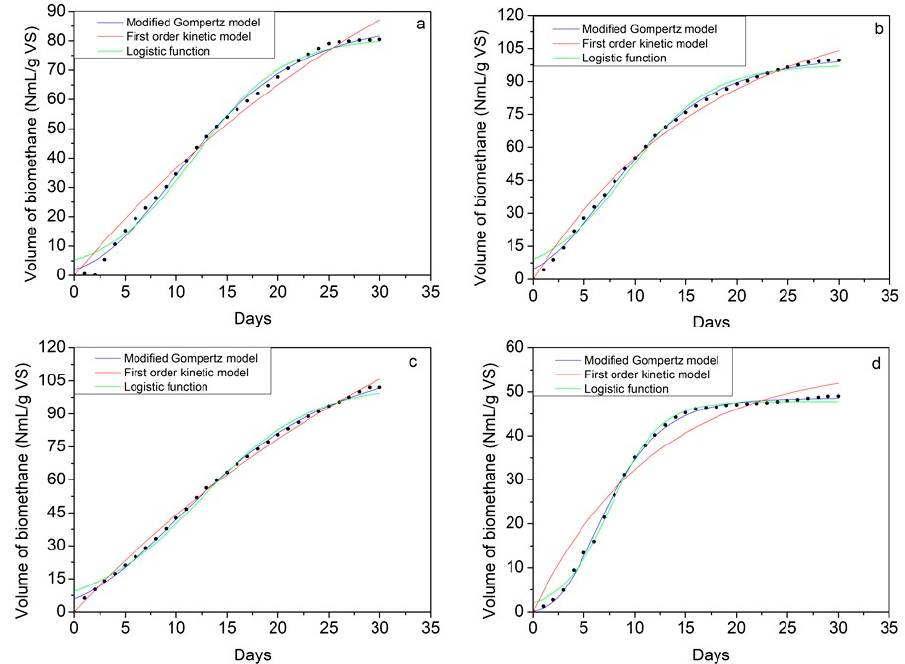
Figure 5. Experimental data fitted by the modified Gompertz, the first-order kinetic model, and the logistic function model—( a ) sample S , ( b ) sample S +5 , ( c ) sample S +10 , ( d ) sample S +50 . All of the parameters estimated using the three fitted kinetic, specifically, the hydrolysis rate constant (first order, k ), lag phase duration ( m ), maximum biogas